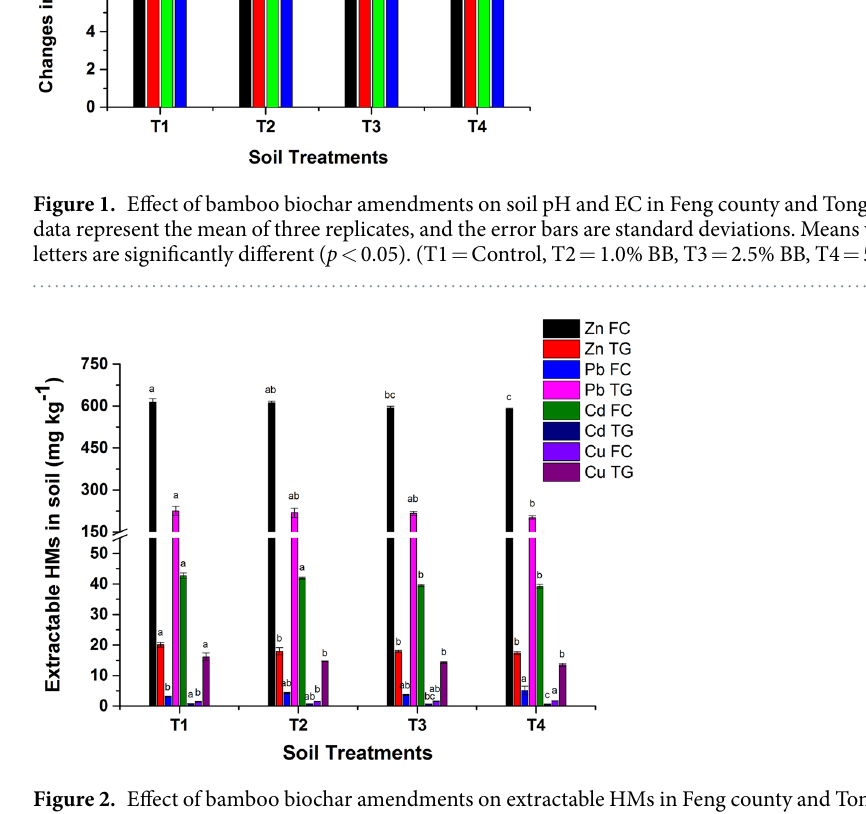
Figure 2. Effect of bamboo biochar amendments on extractable HMs in Feng county and Tongguan. The data represent the mean of three replicates, and the error bars are standard deviations. Means with different letters are significantly different ( p < 0.05). (T1 = Control, T2 = 1.0% BB, T3 = 2.5% BB, T4 = 5.0%